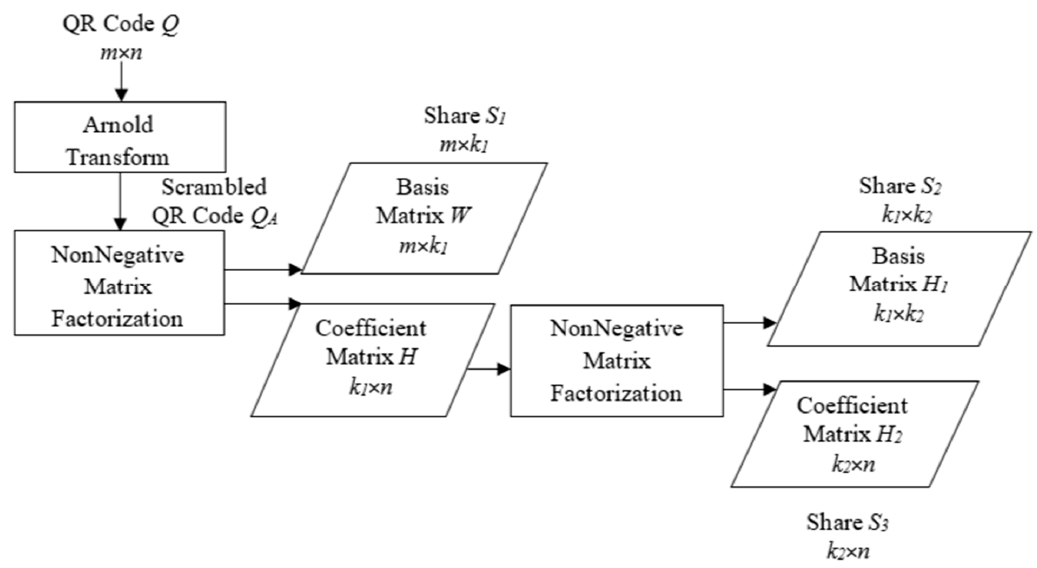
Figure 5. Secret-share construction .